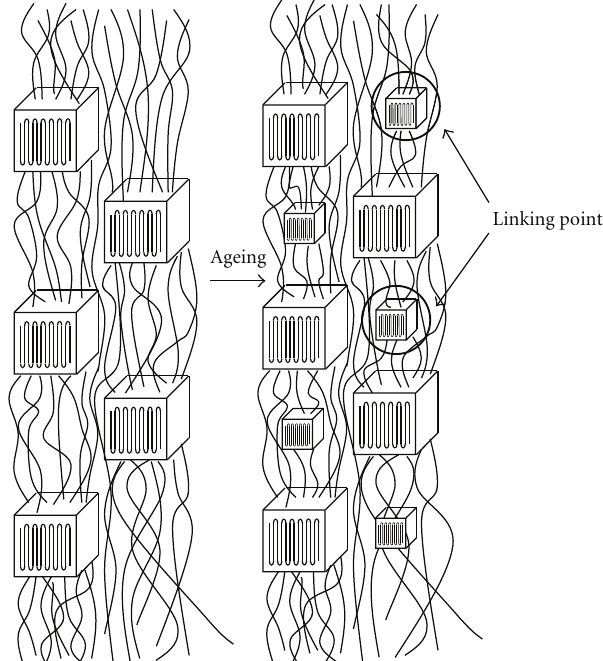
Figure 20: appearance of crystallites in the amorphous areas: the break of diethylene glycol groups existing in the amorphous areas may promote the crystallization process and thus the transforma- tion of CIS conformers (present in the amorphous zones) in TRANS (present in the crystalline